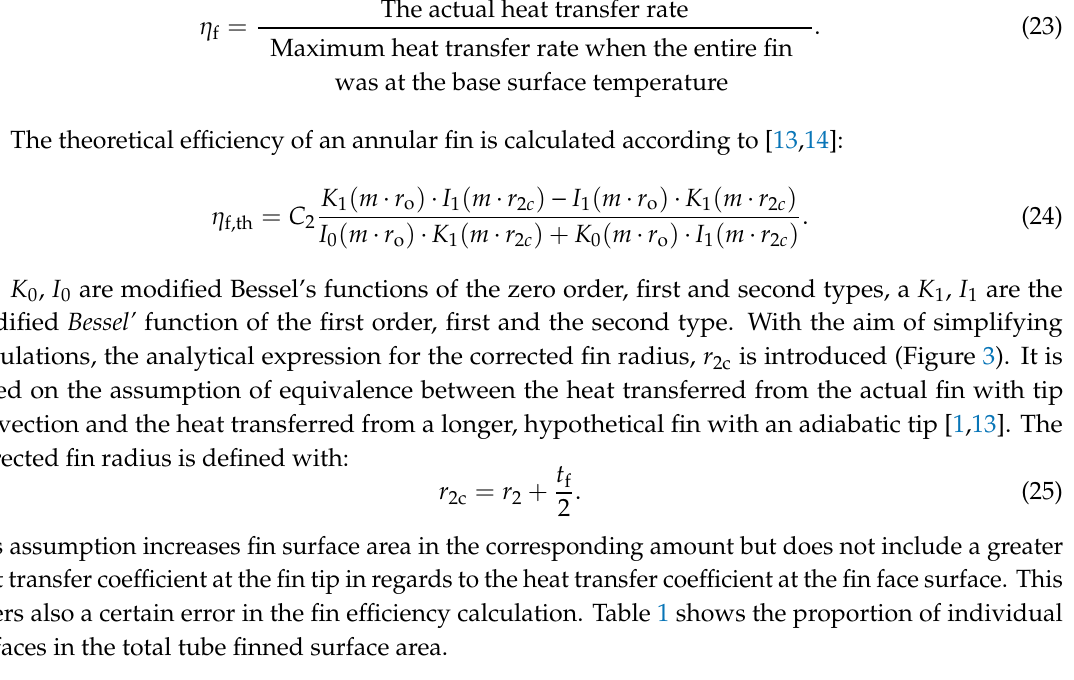
Table 1. The share of individual surfaces in the total surface